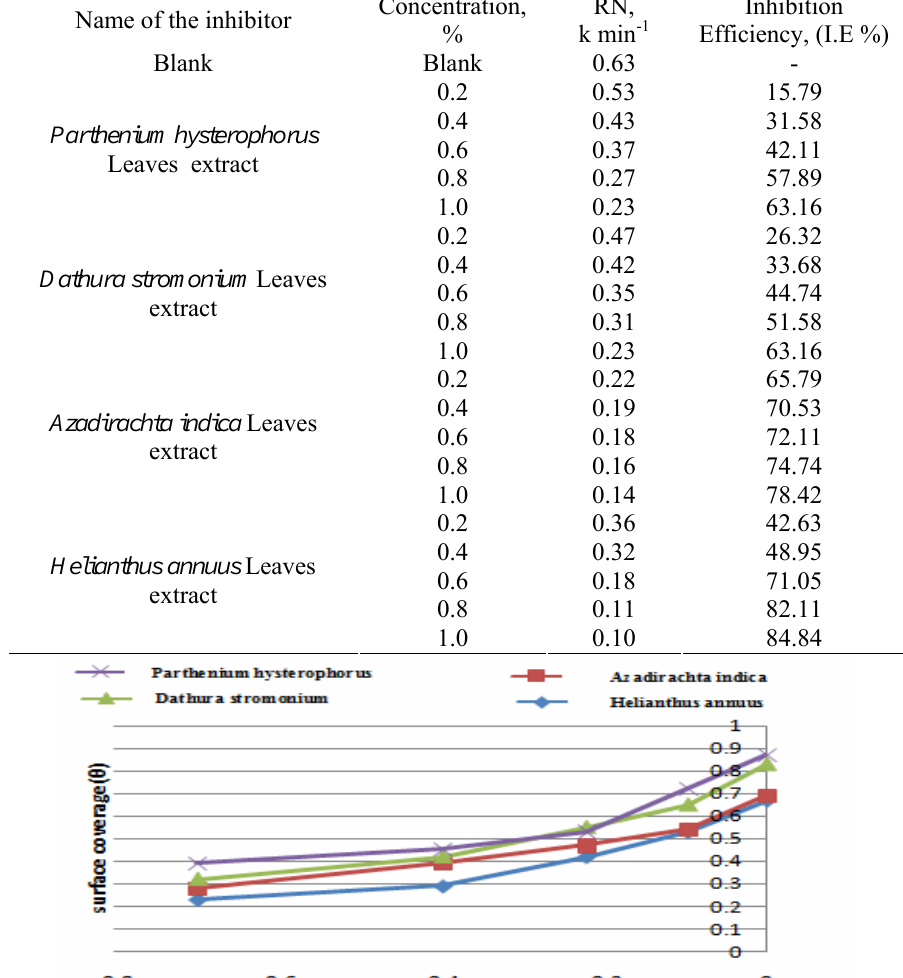
Table 3. Variation of reaction number (RN k min -1 ) at various concentrations of all four